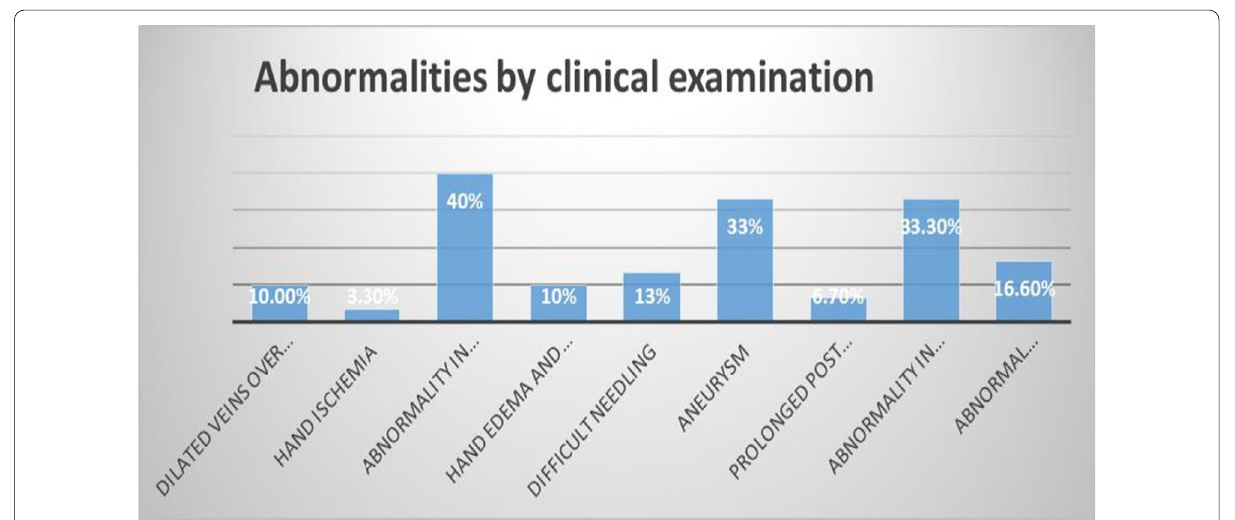
Fig. 1 Abnormalities by clinical examination